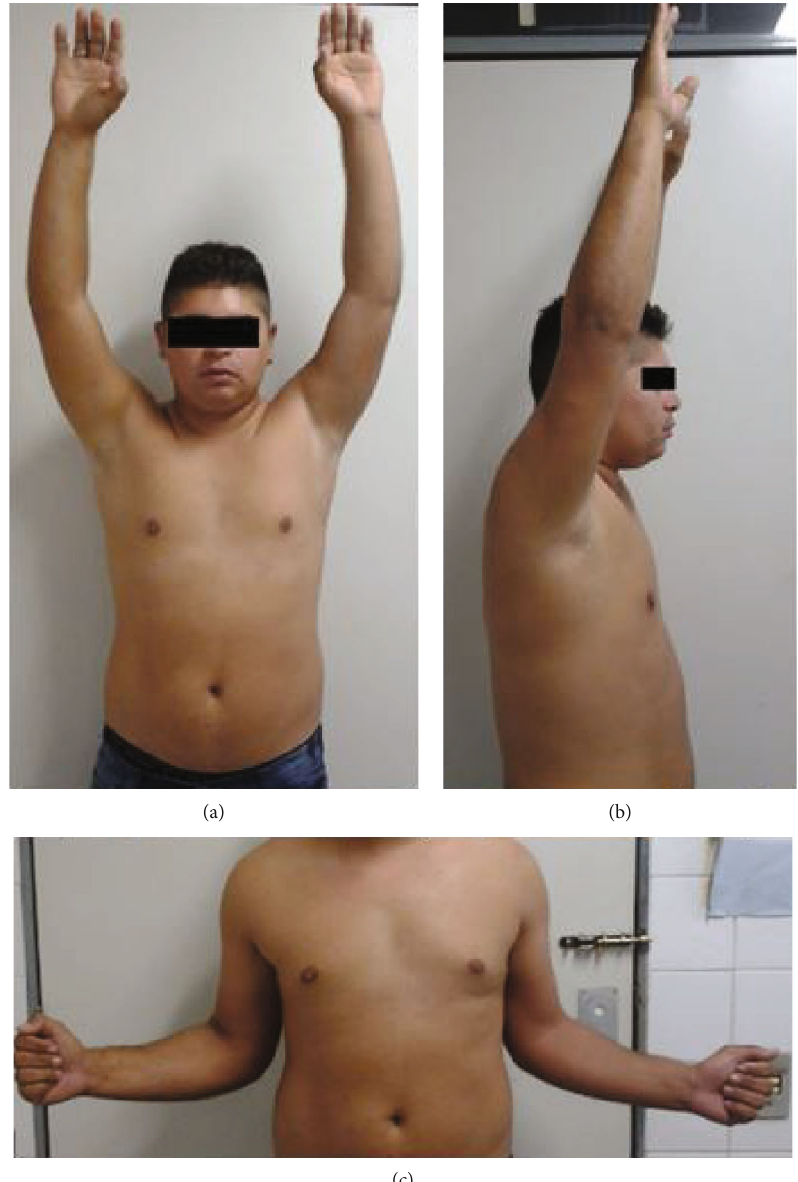
Figure 2: After two years of follow-up, there was complete recovery of shoulder movement. (a) arms elevation — anterior view. (b) arm elevation — side view. (c) external rotation.